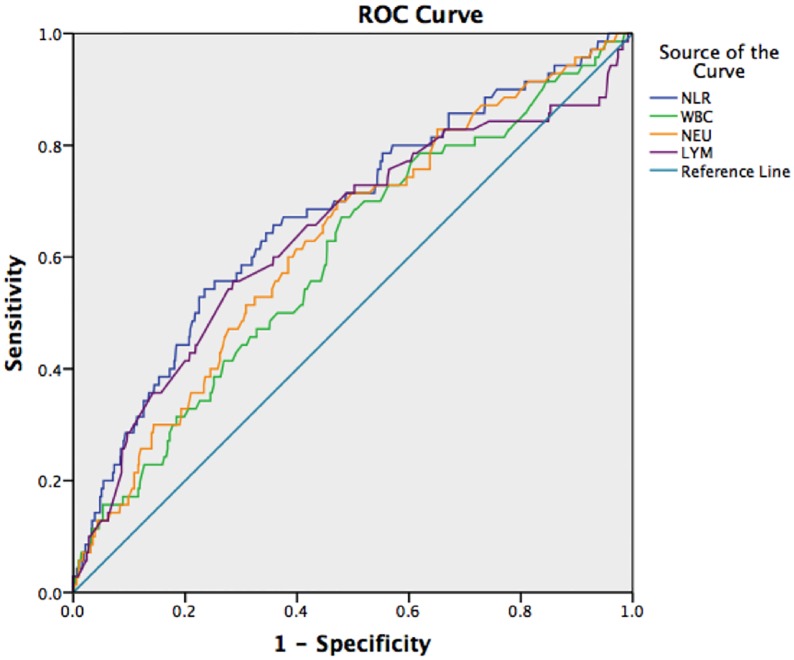
ROC curves of NLR, WBC, NEU, and LYM to predict the ICU occupancy rate.